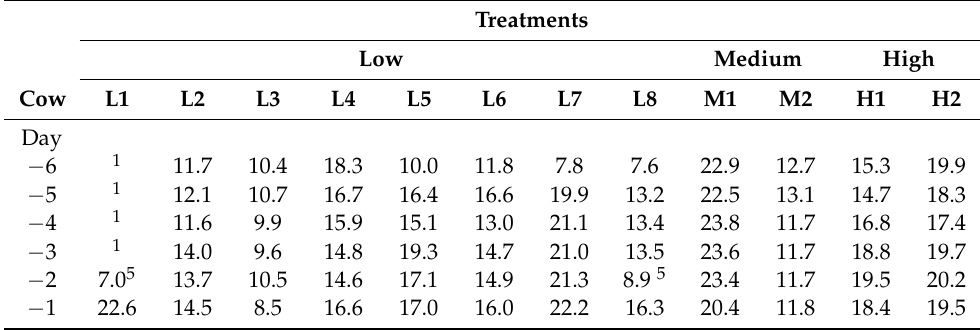
Table 5. Individual milk yield (kg/d) of the dairy cows during the experiment. Day − 6 is relative to the first day of offering the seaweed mix containing A. taxiformis